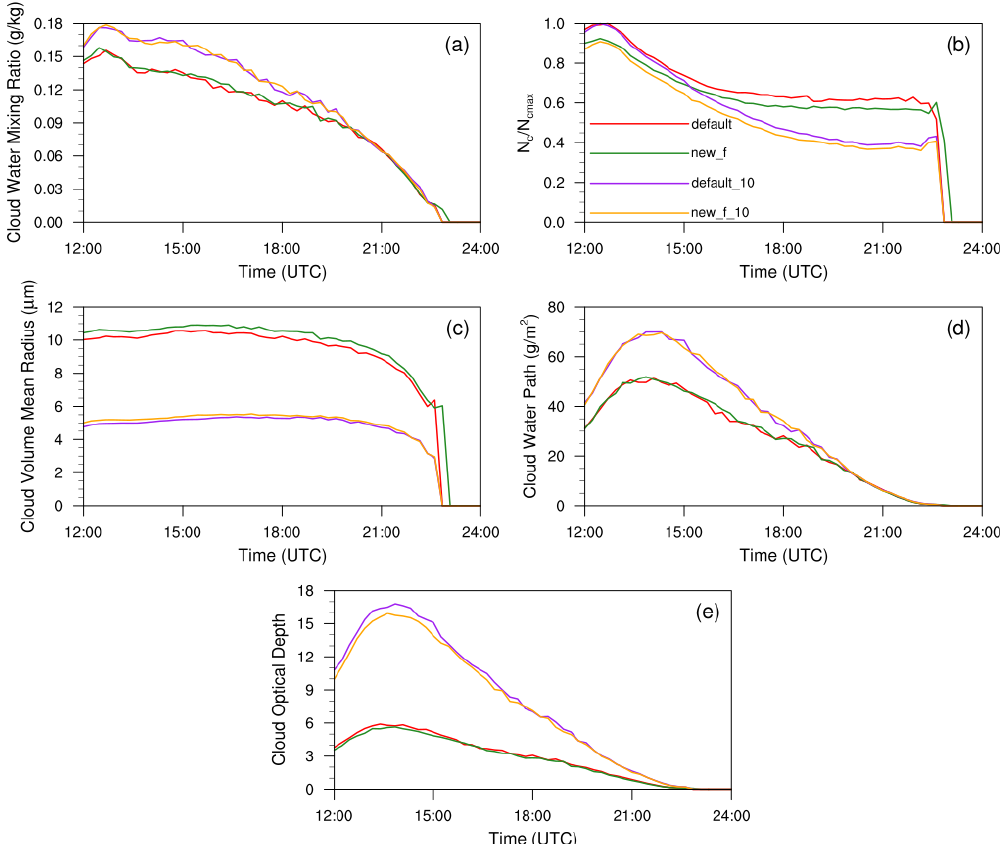
Figure 10. The temporal evolutions of main cloud microphysical and optical properties in all simulation experiments for the stratocumulus case, including (a) cloud water mixing ratio ( q c ) (gkg − 1 ), (b) cloud droplet number concentration ( N c ) (cm − 3 ), (c) cloud droplet volume mean radius ( r v ) (µm), (d) cloud water path (CWP) (gm − 2 ), and (e) cloud optical depth ( τ ). In (b) , N c values in the experiments default and new are normalized by the maximum cloud droplet number concentration ( N cmax ) from default ; N c values in the experiments default_10 and new_10 are normalized by N cmax from default_10 ; new_f and new_f_10 are the experiments using entrained air relative